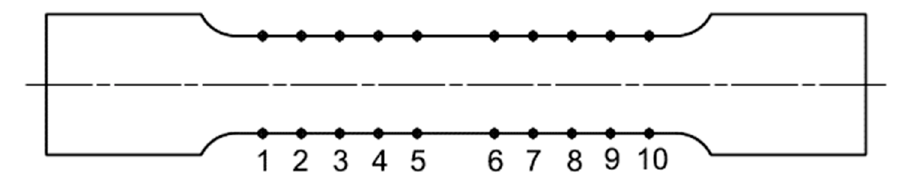
Figure 7. Selected locations for control measurements along the functional length dimension of specimen.